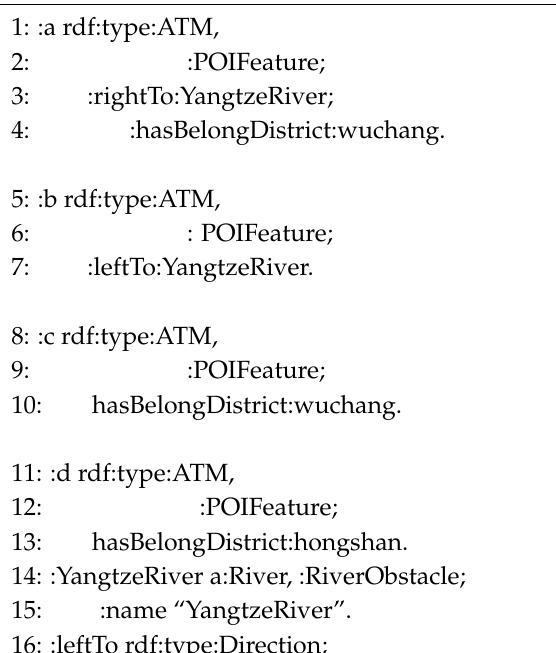
Algorithm 1. The Definitions of Points a , b , c and d, the Property “ hasRiverObstacle ”, “ hasMustLink ” and “ hasCannotLink ” and the Relevant